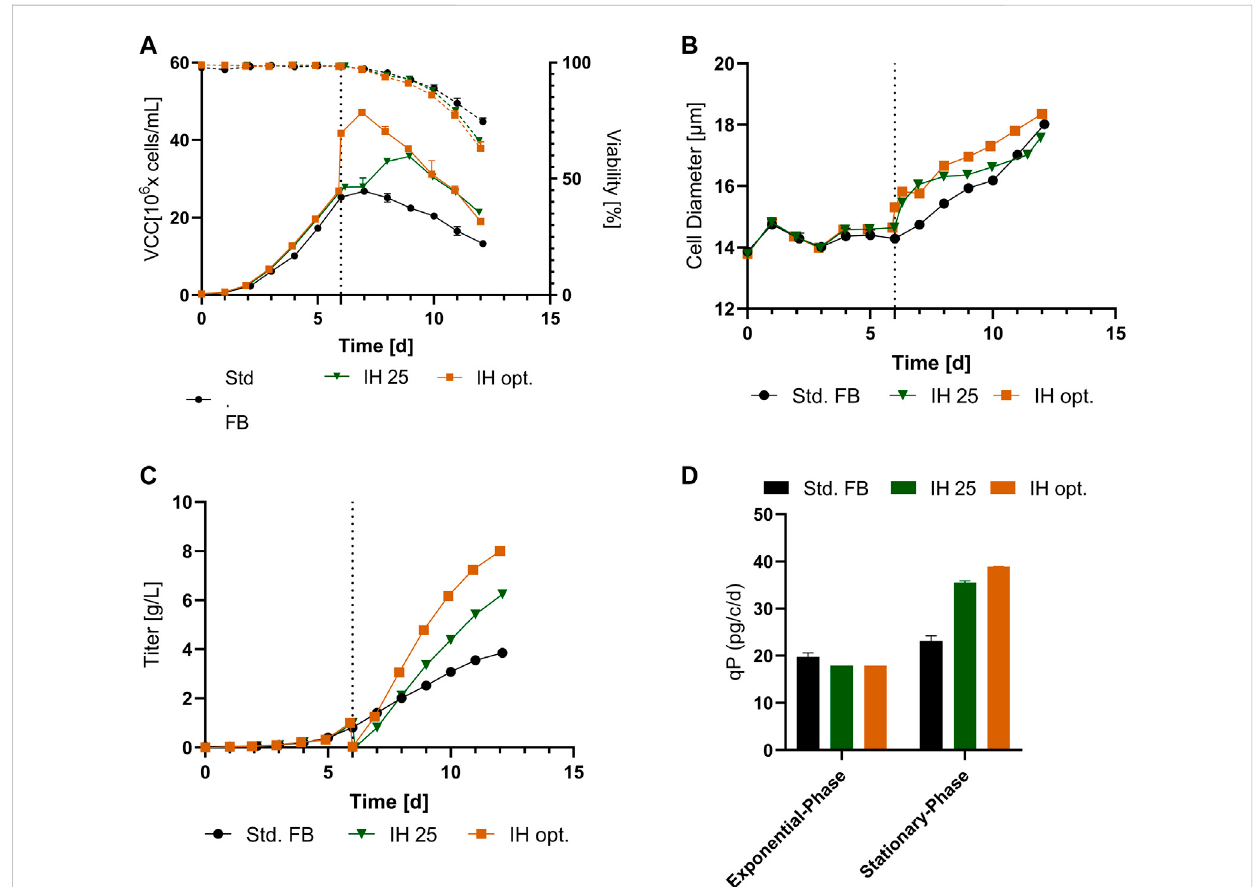
FIGURE 4 Results for cultivation transferred from a 5-L reactor to a 250-mL downscale model after an IH operation. (A) VCC (solid line) and viability (dotted line)pro fi lesovertimeforstandardFB,theIHapproachreinoculatedat25×10 6 cells/mL(IH25),andtheoptimizedIHprocess(IHopt.)with n =2foreach. (B) Cellular diameter for all approaches overtime. (C) mAb titer (g/L) over the course of cultivation. (D) Cell-speci fi c productivity (qP) in pg/c/d for the exponential and stationary phases for each of the conducted